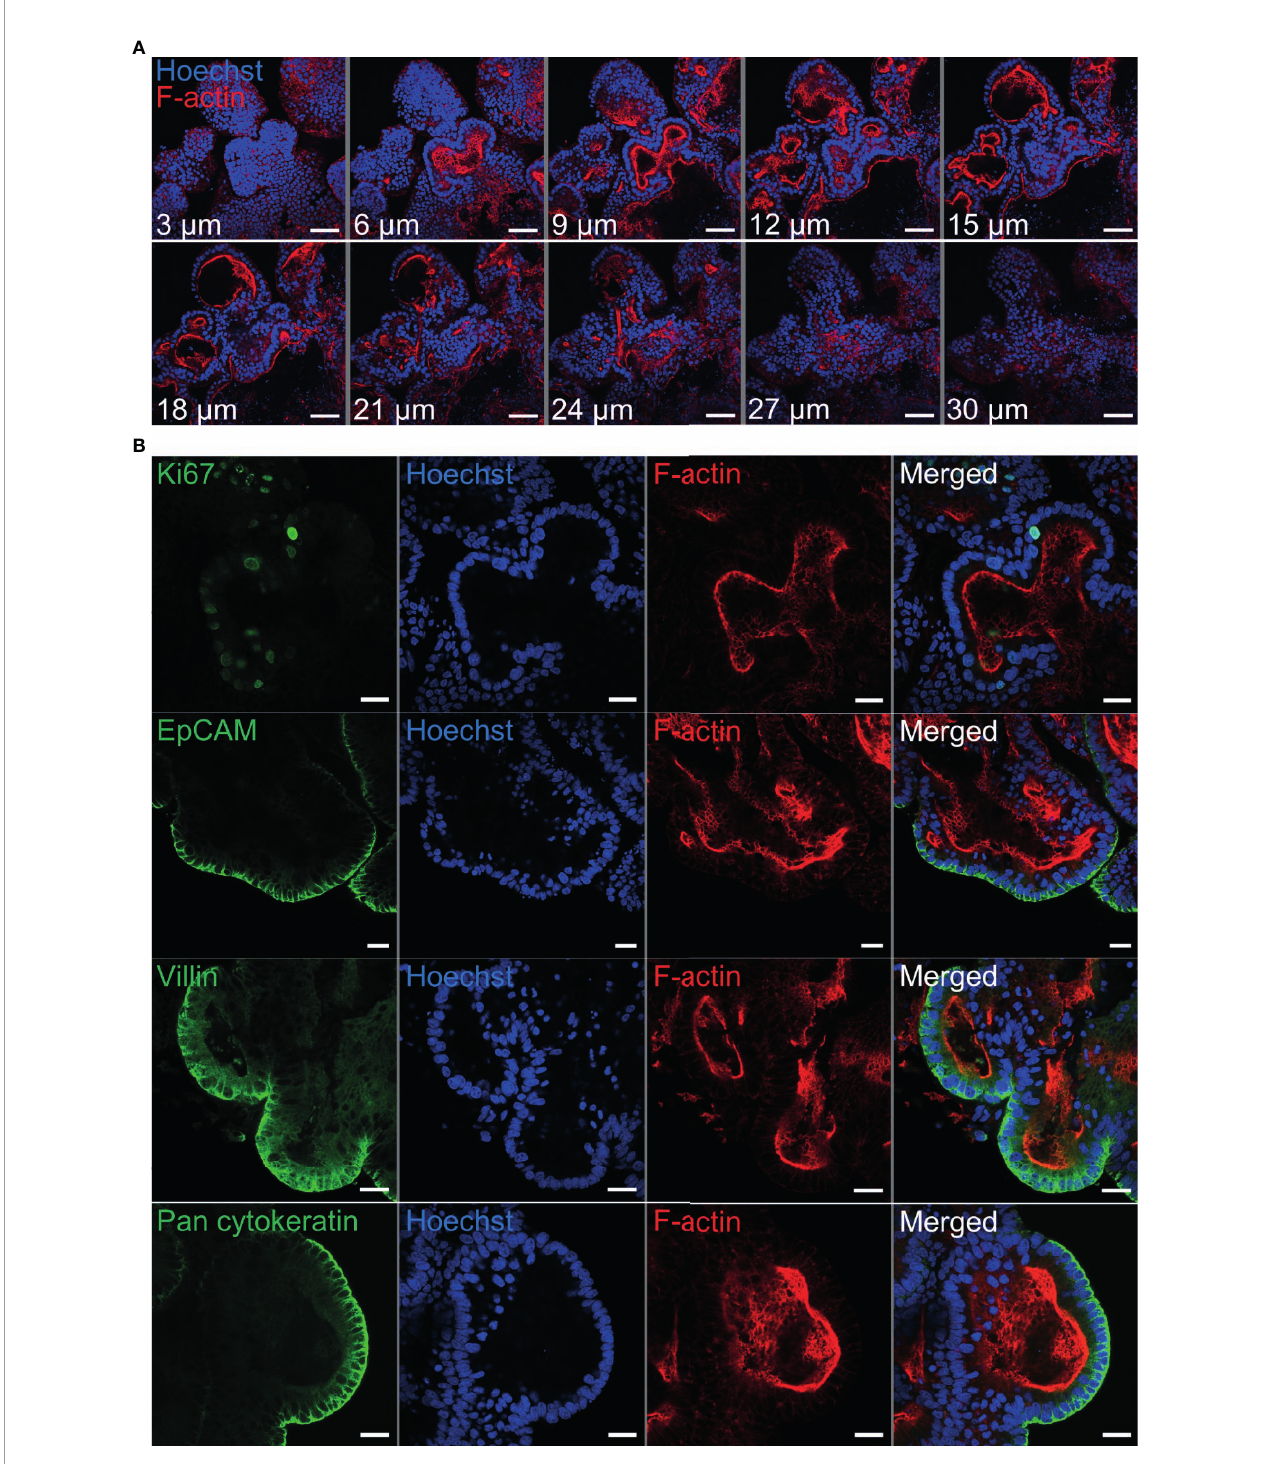
FIGURE 4 | Characterisation of ovine ileum organoids by immuno fl uorescence confocal microscopy at seven days of in vitro culture. (A) Representative Z-stack images of part of an individual branched ileum organoid with a closed luminal space and an internal F-actin-expressing brush border. Red = F-actin and blue = Hoechst (nuclei). (B) Representative images of abomasum organoids probed for either the cell proliferation marker Ki67, or the epithelial cell markers EpCAM, villin and pan-cytokeratin (all green). F-actin (red) and Hoechst (blue). Scale bars = 10